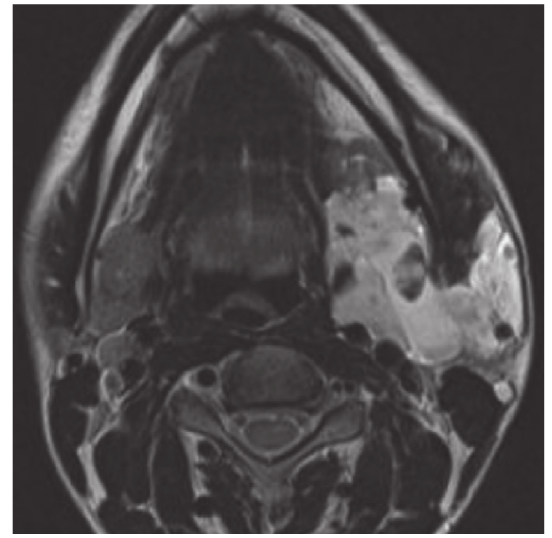
Figure 7: Axial-section T 2-weighted MRI sequence showing a well-marginated lesion involving whole of the left parotid gland, hyperintense with lobulated hypointense foci within